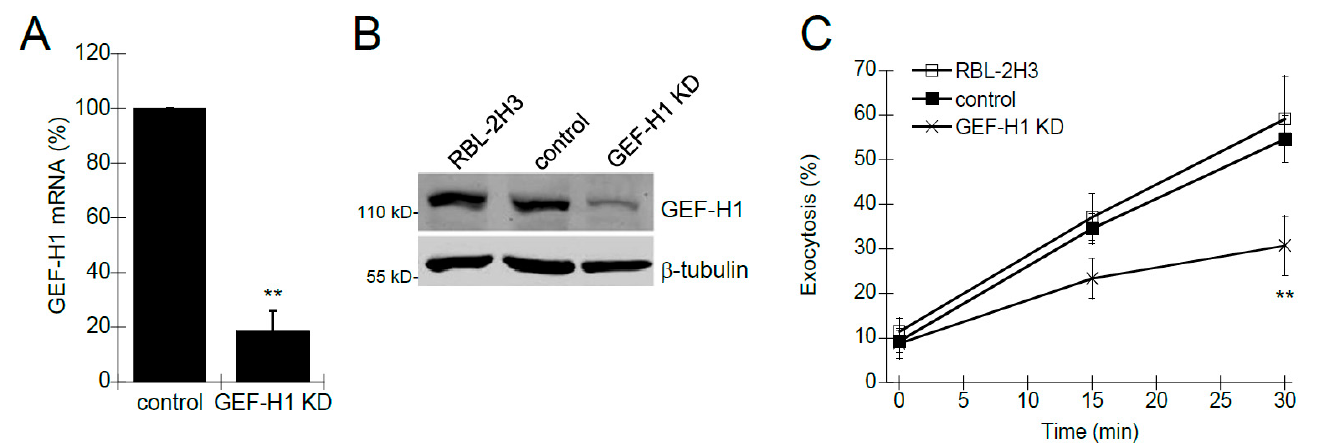
Figure 1. The Effect of GEF-H1 knockdown (KD) on mast cell degranulation. GEF-H1 expression was reduced in RBL-2H3 cells using RNA interference and the effect on degranulation was assayed. ( A ) qPCR was used to quantify levels of GEF-H1 mRNA in control cells infected with the shRNA vector or GEF-H1 shRNA ( GEF-H1 KD ). Calculated 2 − ΔΔ Ct values were normalized relative to the control. A 81.3% reduction in GEF-H1 mRNA was observed in the GEF-H1 KD strain (** p = 0.0090 comparing the reduction in GEF-H1 expression in GEF-H1 KD to the control by one-tailed Student’s t -test; n = 3). ( B ) Immunoblot was used to confirm the reduction in GEF-H1 protein in the GEF-H1 KD strain. ( C ) Degranulation assays were used to determine the effect of GEF-H1 depletion on mast cell granule exocytosis and were statistically analyzed by one-way ANOVA ( p < 0.001; n = three independent blots). Post hoc Tukey’s tests revealed GEF-H1 knockdown significantly reduced exocytosis in pairwise comparisons between RBL-2H3 and control strains after 30 min of stimulation (**p < 0.001 and 0.00314 for RBL-2H3 and control strains, respectively).